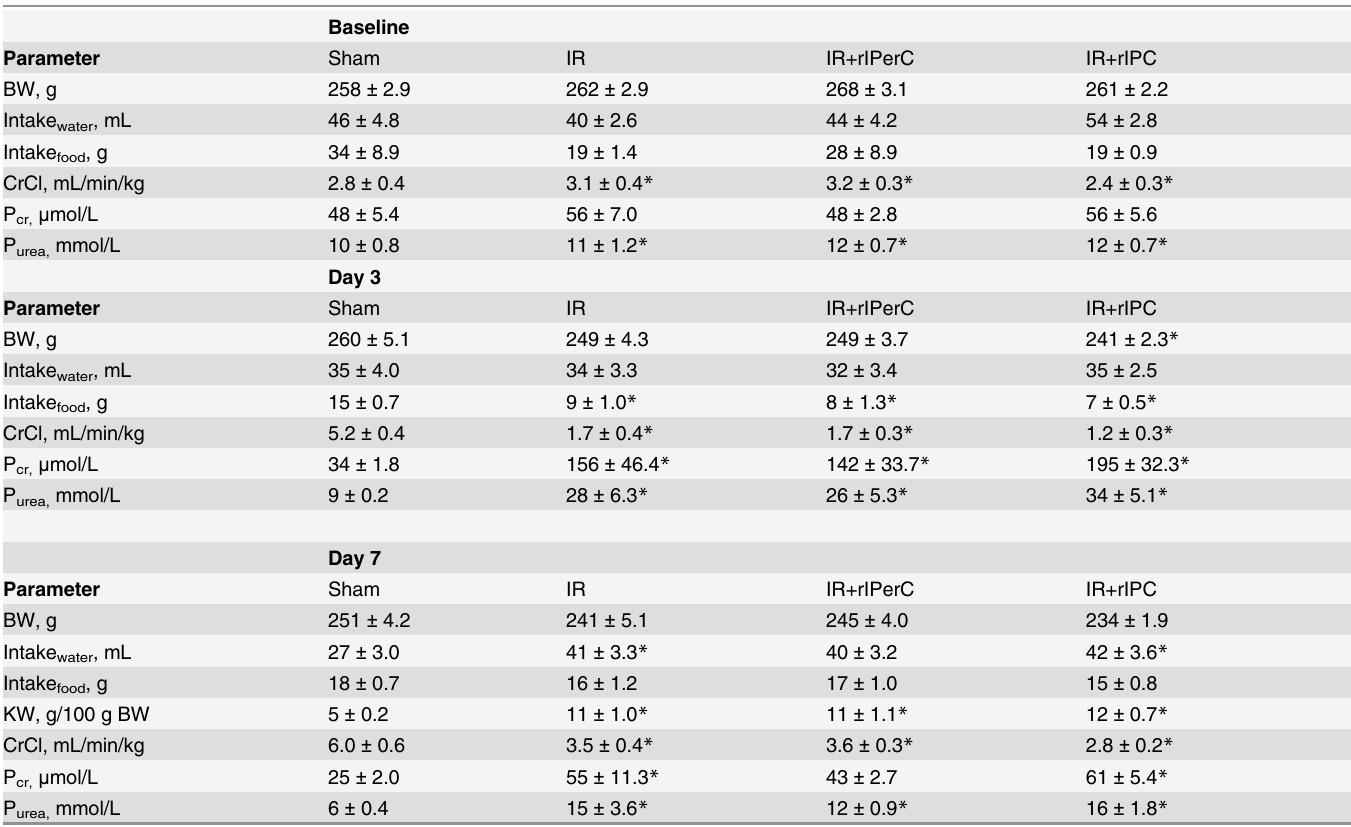
anti-oxidant enzymes CAT and MnSOD (p = 0.004, p < 0.0001, respectively), whereas rIC did not affect their levels compared to IRI alone (Fig 4E and 4F). The expressions of active phosphorylated MAPK pAkt and pERK1/2 were markedly up-reg- ulated after IRI compared with sham treatment (both p < 0.0001) (Fig 5A – 5C). There was no additional change in these levels in relation to rIPC or rIPerC. Total protein levels of Akt and Table 3. Physical, plasma, and urine parameters.